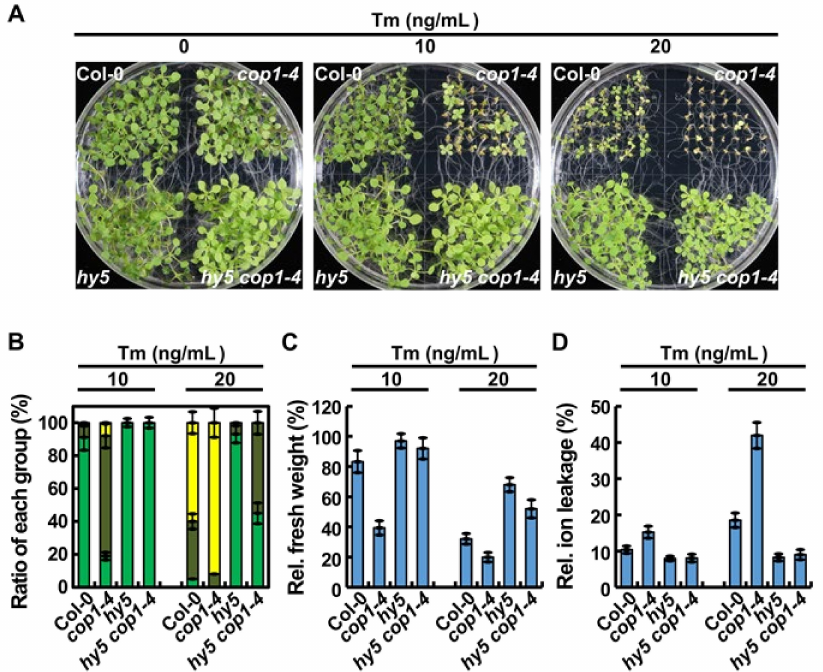
Figure 6. The hy5 mutant locus confers ER stress resistance in cop1-4 plants. ( A ) Phenotypes of 2-week-old WT (Col-0), cop1-4 , hy5 , and hy5 cop1-4 seedlings grown on MS medium containing 0, 10, or 20 ng/mL Tm. ( B ) Percentage of plants of each genotype in the three classes, G-B, G-S, and Y-S, depending on their sensitivity to Tm. Data represent mean ± SD ( n = 3). ( C , D ) Relative fresh weight ( C ) and electrolyte leakage ( D ) of plants treated with Tm, as indicated in ( A ). Data represent mean ± SD ( n =